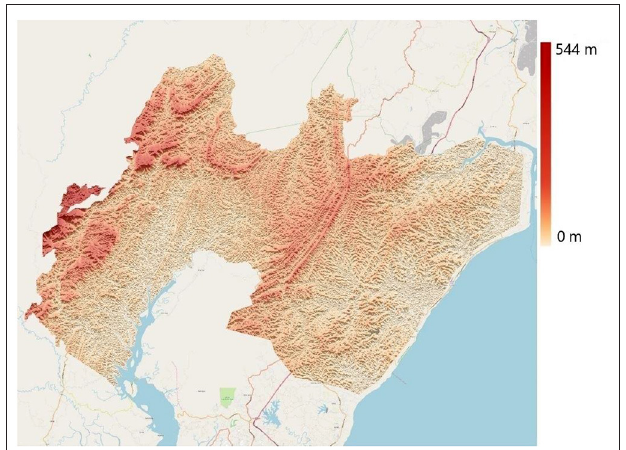
FIGURE 6 | Aspect